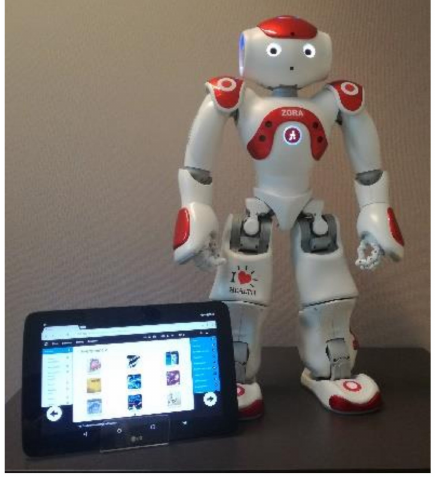
Figure 1. A picture of the care robot Zora with a tablet for control.